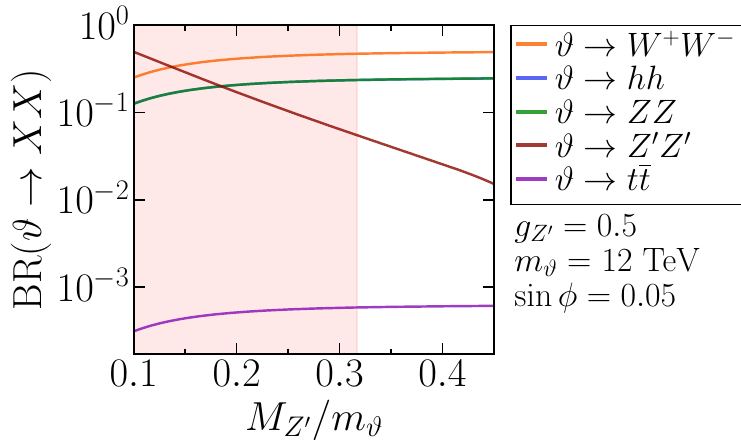
Figure 6. Flavon BRs as a function of the mass ratio M Z 0 /m ϑ when the flavon is much heavier than the Z 0 and the U (1) B gauge coupling is order one. As the mass ratio is lowered, we see 3 − L 2 that the Z 0 Z 0 final state becomes increasingly important. The region excluded at the 95% CL by LHC data, for this particular choice of parameters, is shown in pink. The green and blue lines are overlap to such a degree that they are indistinguishable by eye.